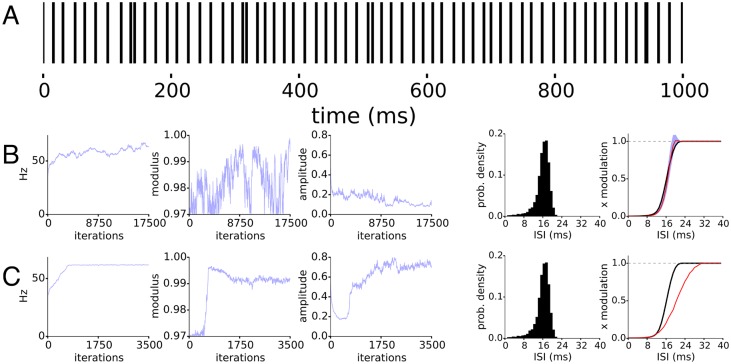
A) limiting case where models are not identifiable. The spike train in A is nearly periodic, but generated without an oscillatory modulation. When using the standard knots, the latent state amplitude approaches 0, B, but when we use a fixed history that is very different than the ground truth, C, the sampled parameters appear to be very certain, and an oscillation at 62Hz, nearly the spiking frequency, 64hz, is inferred. For cases where the spike train itself is nearly periodic, the spike train may be described equally well with various combinations of spike histories and an oscillation at the spiking frequency.